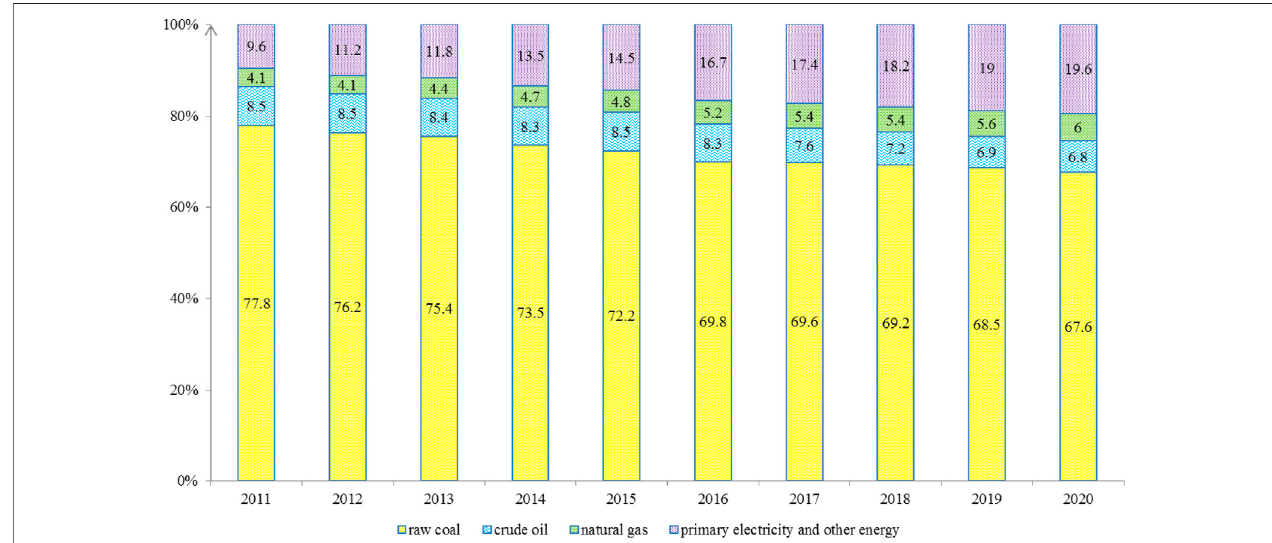
FIGURE 3 | Composition of primary energy production in China during 2011 – 2020 (%). Source: The author searched the information from Total Primary Energy Production and Its Composition in the China Statistical Yearbook 2021.